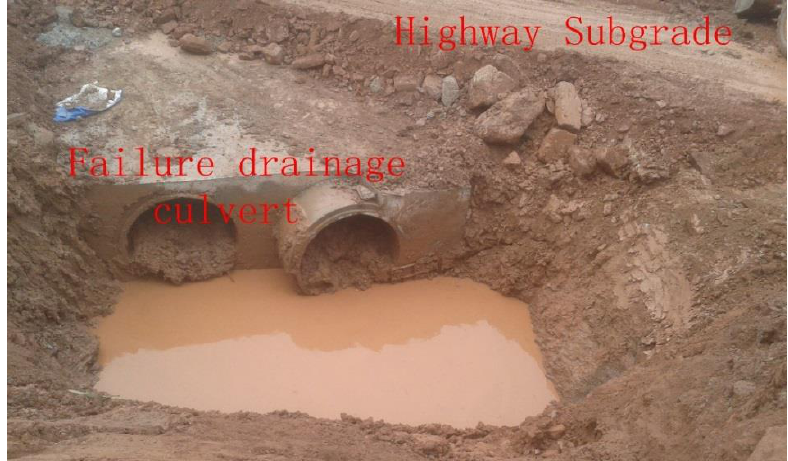
Figure 10. Drainage culvert failure at foot of slope.